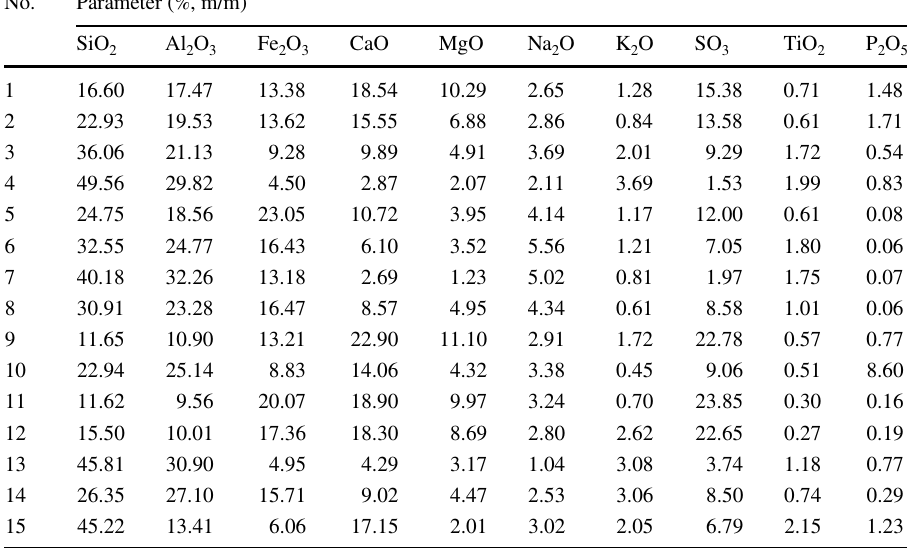
Table 5 Oxide composition of ashes in Sample No. 15-